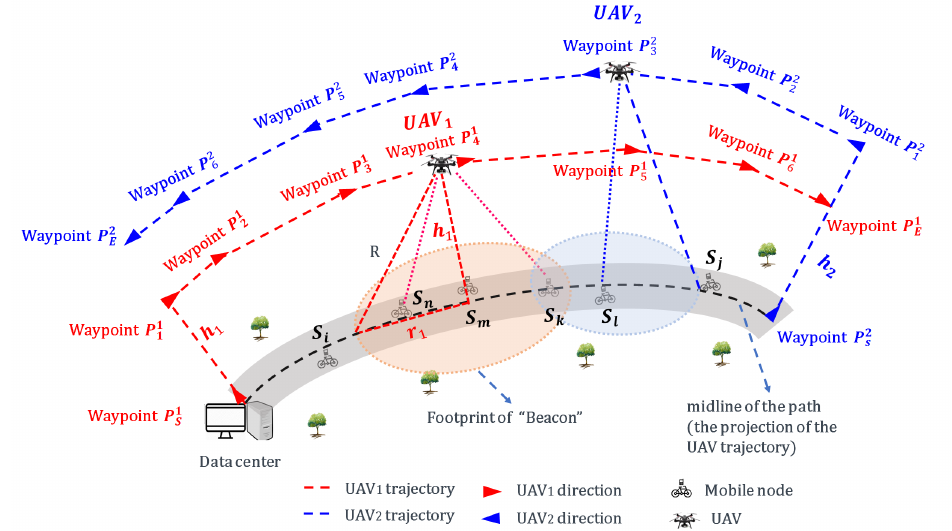
Figure 1. An illustration of the unmanned aerial vehicle (UAV)-aided data collection for a mobile → Waypoint wireless sensor network. The exemplar trajectory of the UAV 1 is shown as: Waypoint P 1 S → Waypoint P 1 → Waypoint P 1 → Waypoint P 1 → Waypoint P 1 → Waypoint P 1 → Waypoint P 1 P 1 E 2 3 5 6 1 4